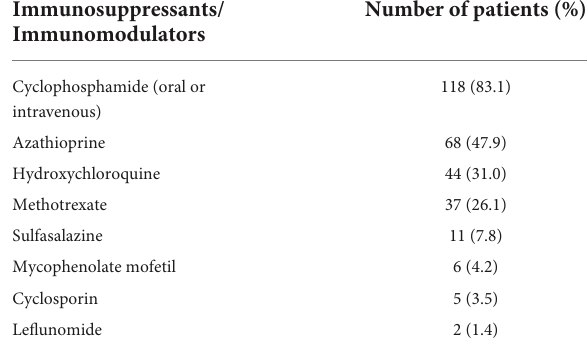
TABLE 1 Baseline demographics and comorbidities in patients with granulomatosis with polyangiitis (GPA) and control cohorts. Characteristics